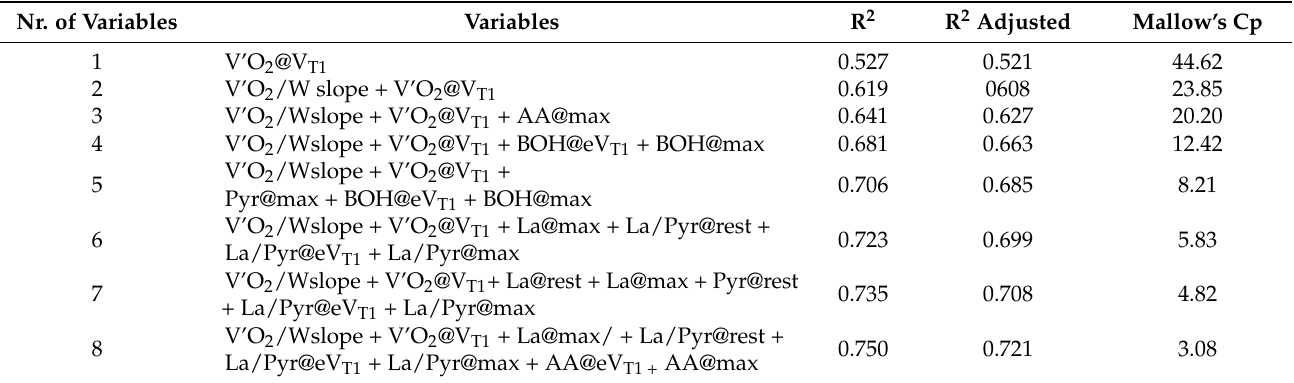
Table 2. Multivariate model analysis using functional exercise parameters and V’O 2 -adjusted biologi- cal parameters in healthy and muscle complaint subjects ( n = 240) to explain V’O 2max . (@rest: resting value; @V T1 : at first ventilatory threshold; @max: at the acme of effort), AA: acetoacetate; BOH: β -hydroxybutyrate; La: lactate; Pyr: pyruvate; V’O 2 /W slope: slope of V’O 2 /work rate relationship change; V’O 2 @V T1 : V’O 2 at first ventilatory threshold; V’O 2max : V’O 2 at the maximal effort. R 2 : model determination coefficient; R 2 adjusted: model determination coefficient adjusted to the number of variables; Mallow’s Cp: Cp coefficient of